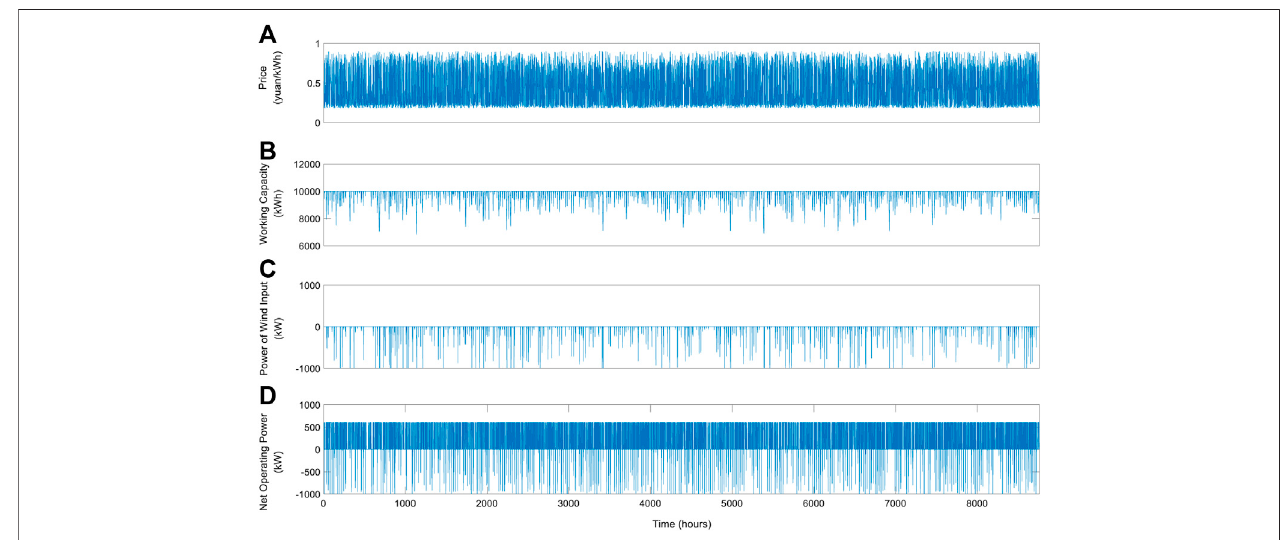
FIGURE 5 | Working capacity and operational strategy changing with electricity prices.